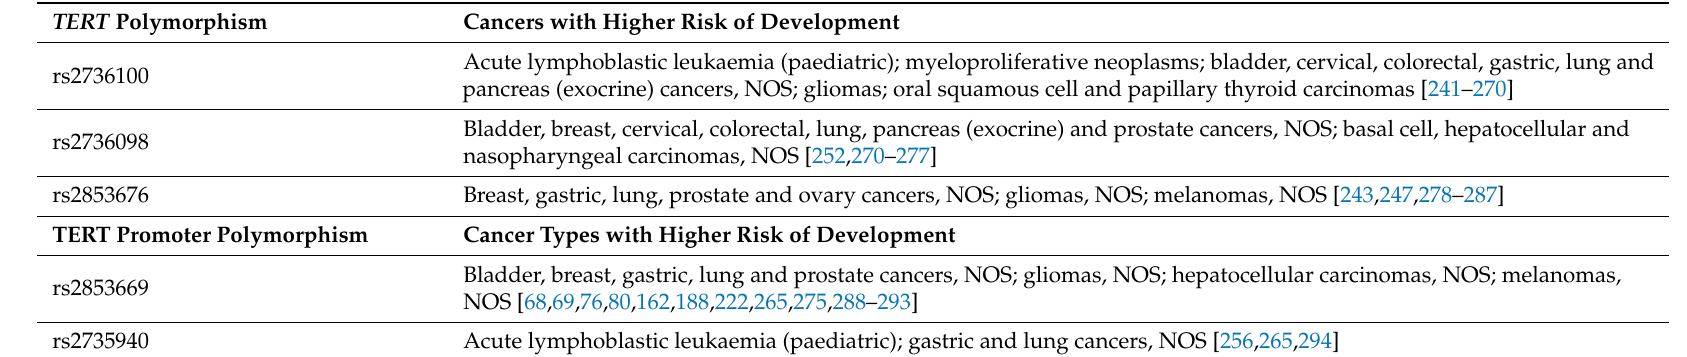
Table 3. Association of the most common TERT and TERTp polymorphisms with the risk of developing